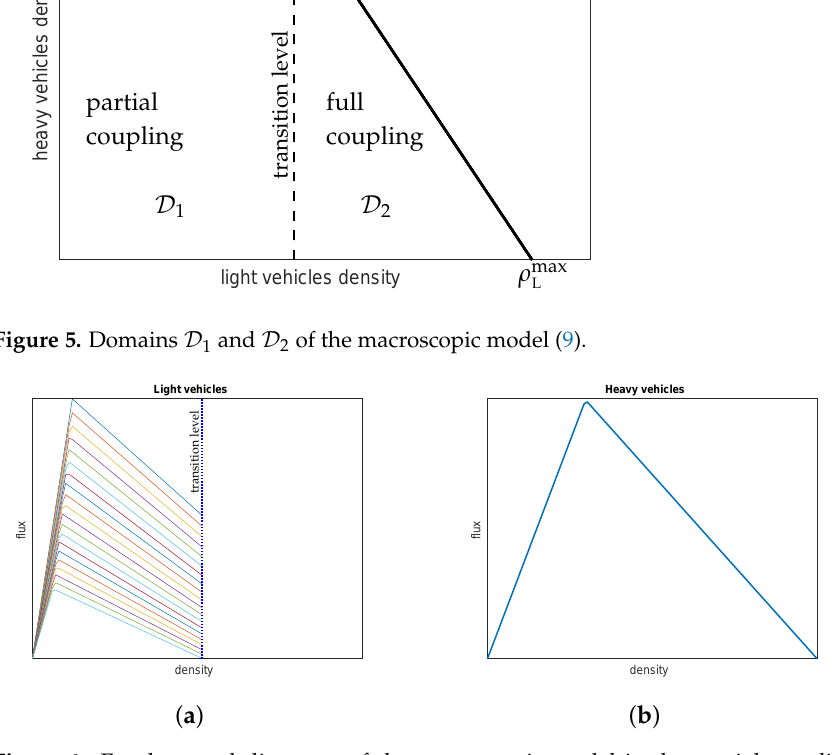
Figure 6. Fundamental diagrams of the macroscopic model in the partial coupling phase, i.e., ( ρ ) . ( a ) Light vehicles, ( b ) heavy vehicles. L , ρ H ∈ D 1